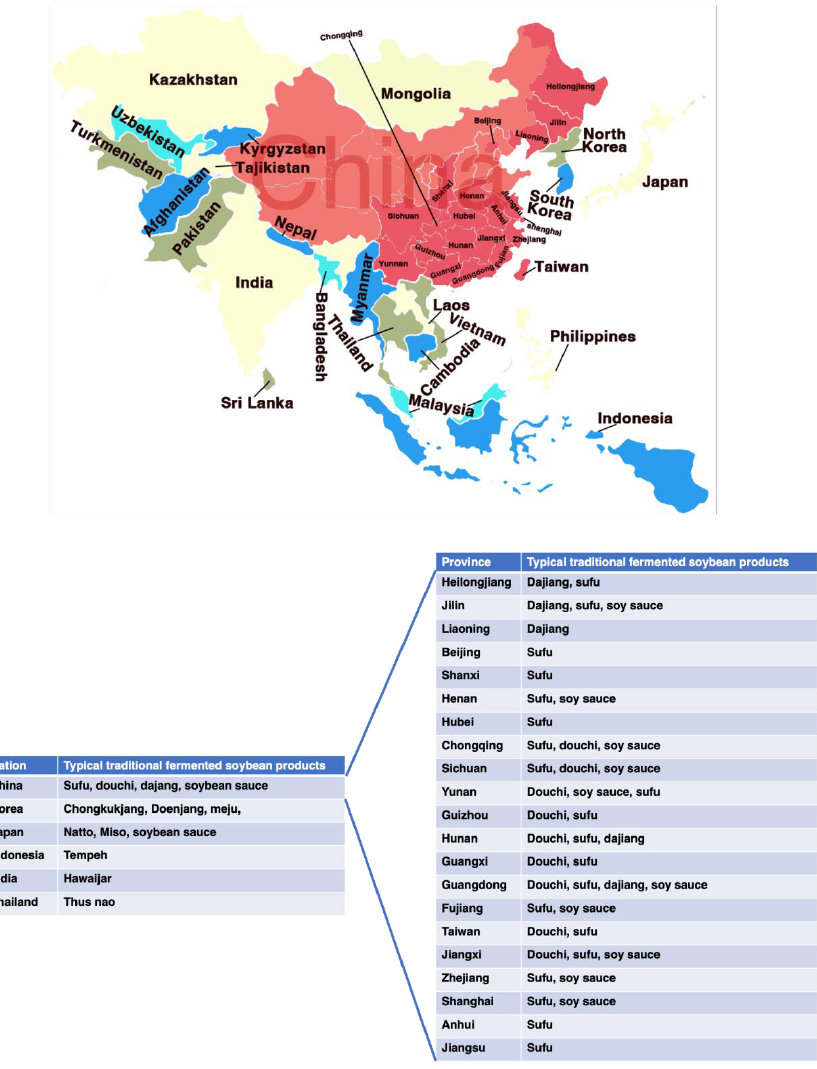
Figure 1. Geographical distribution and variety of traditional fermented soybean products in Asia countries.